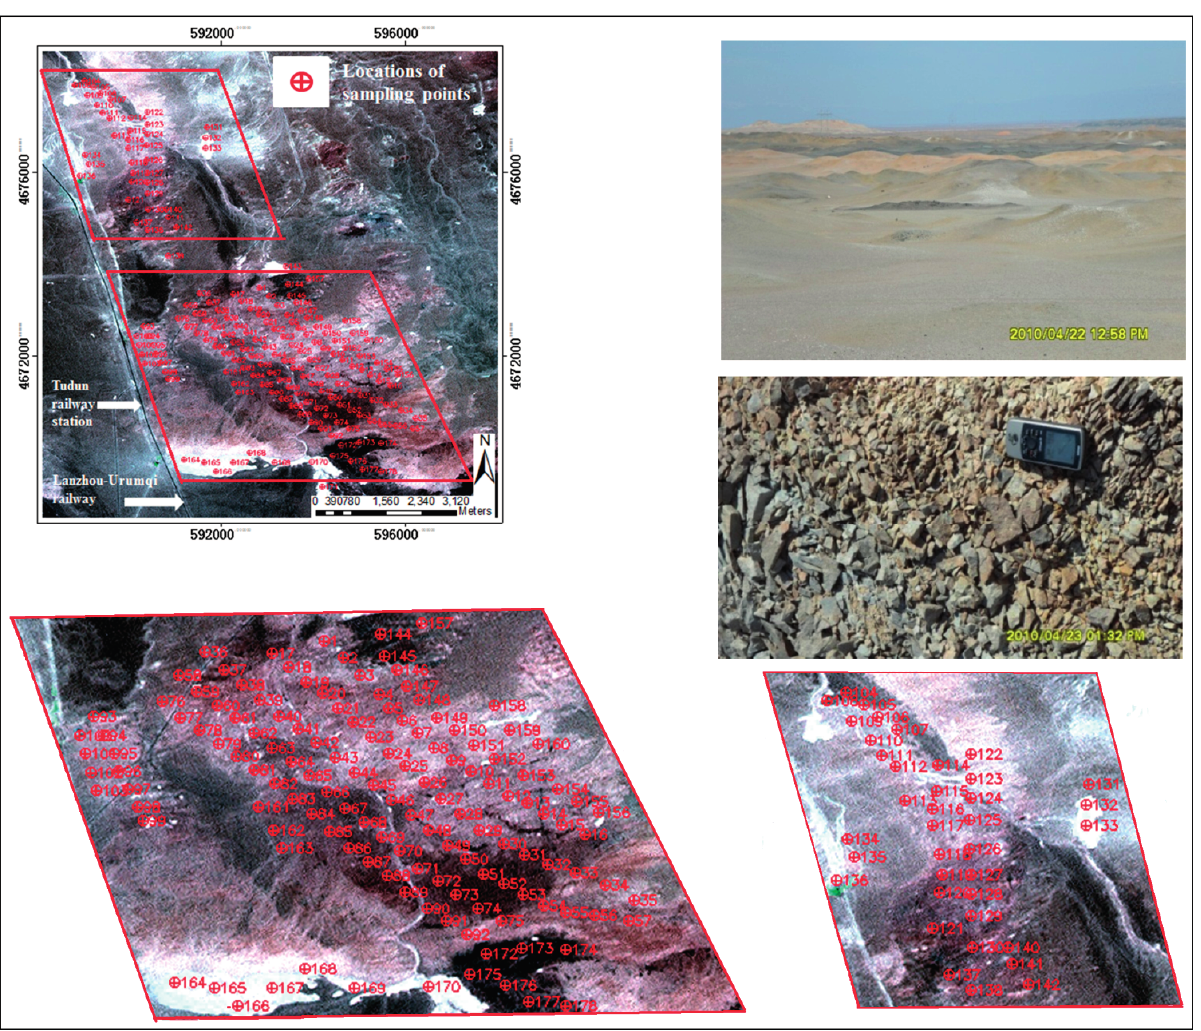
Figure 8. Distribution of sampling point locations.